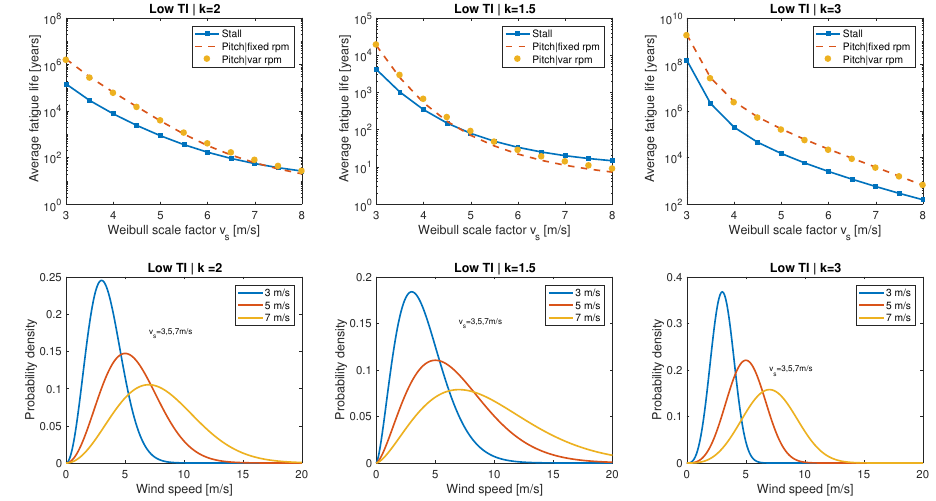
Figure 12. Average fatigue life as a function of the Weibull scale factor v s for all three power regulation schemes, different Weibull shape factors, and low turbulence intensity. Upper row: average fatigue life. Lower row: corresponding Weibull distributions for selected v s